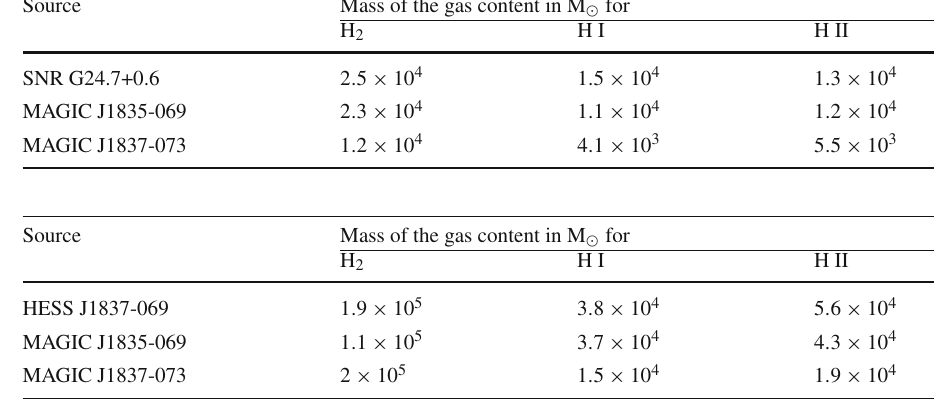
Table 1 The mass of the gas content in the sources at 3.5 kpc.